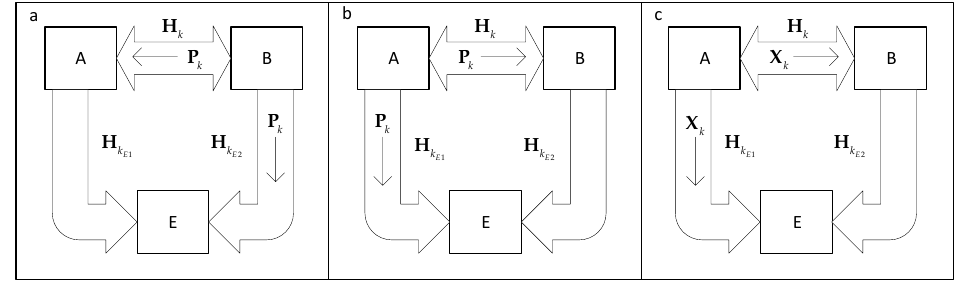
Figure 3. Steps for obtaining the channel estimates. ( a ) the receiver sends a training sequence, P k , that is received by the transmitter and the eavesdropper. ( b ) the transmitter sends a training sequence that is received by the receiver and the eavesdropper. ( c ) the transmitter begins sending data to the receiver, that is also received by the